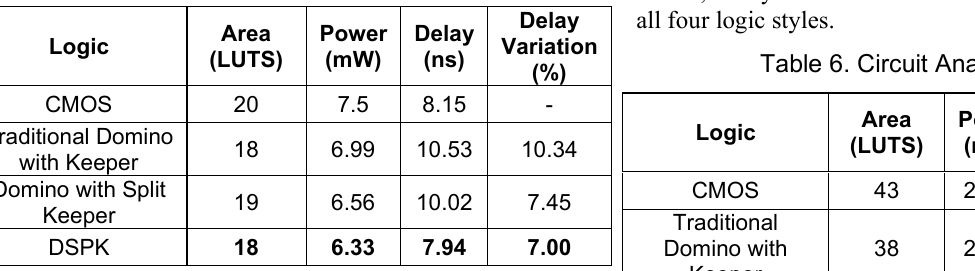
Table 2. Circuit Analysed: NAND2